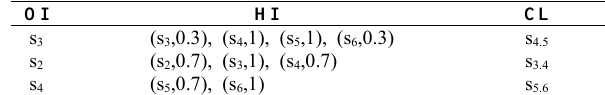
Table 1. Unified results of linguistic values in the set with 5 labels represented by trapezoidal fuzzy